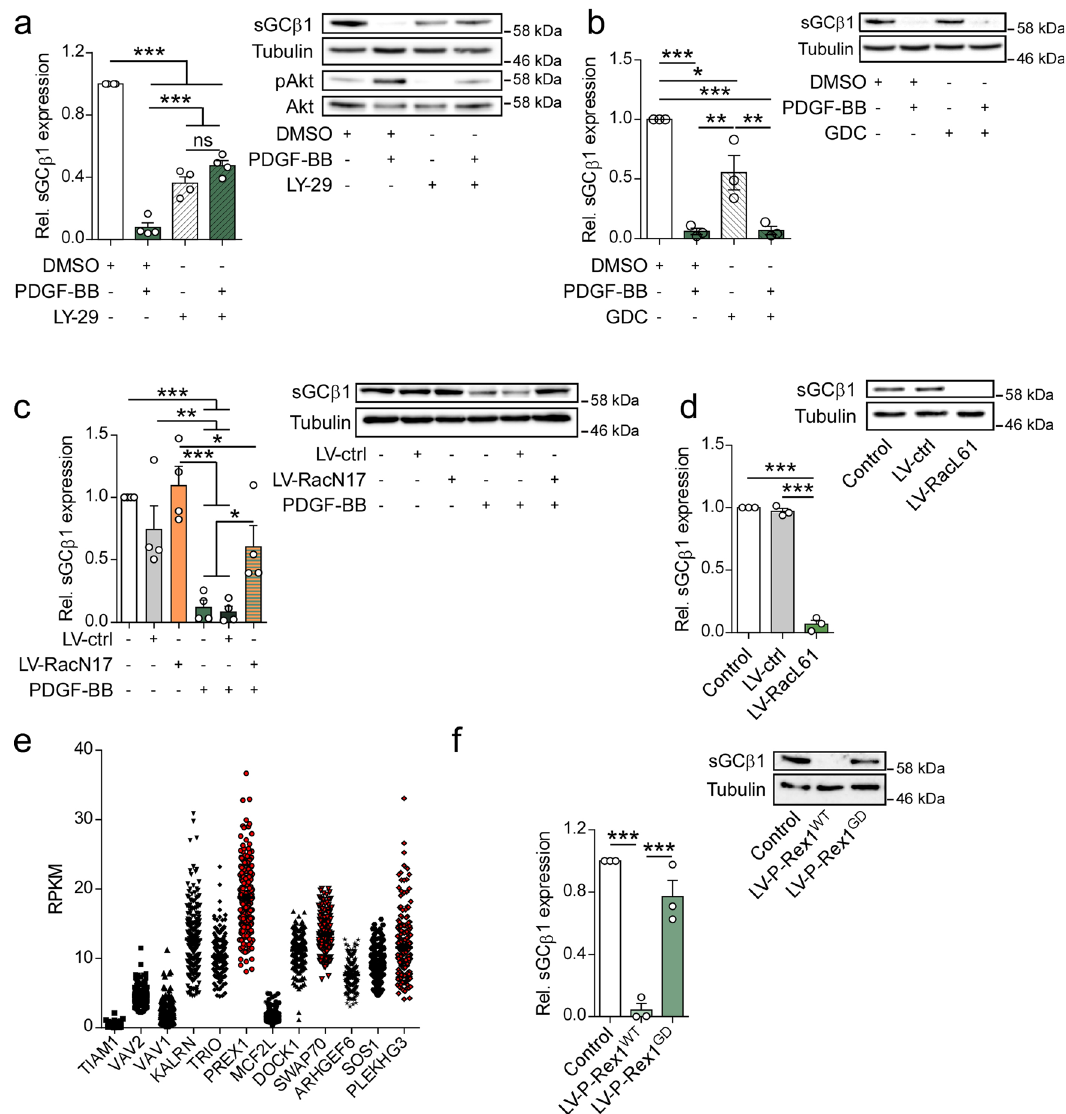
Fig. 2 PDGF-BB reduces sGC expression via a PI3K-Rac1 signaling axis. a sGC β 1 protein expression in hASMCs after treatment with PDGF-BB with